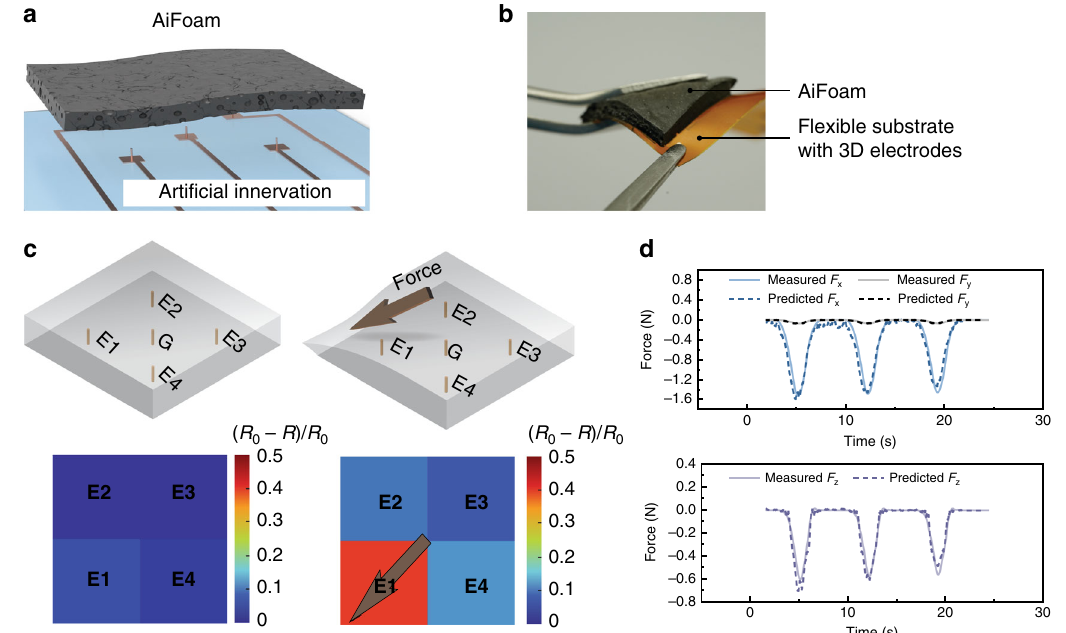
Fig. 5 Direction identi fi cation. a Schematic and b photograph of AiFoam for direction identi fi cation. c AiFoam (with 30 vol% μ Ni) in detecting the direction and force distribution. Top Illustration of the deformation of a pixelated AiFoam sensor before (left) and under (right) external force loading; bottom resistance change response of AiFoam to the external force loadings. E1 – E4 represents the four working electrodes and G represents the ground electrode. R 0 represents the initial resistance of the sensor and R represents the resistance of the sensor during the pressing test. d Measured and predicted forces along different directions based on the result of c . Top Shear-force components along x and y directions ( F x and F y respectively); bottom normal-force components along z -direction ( F z